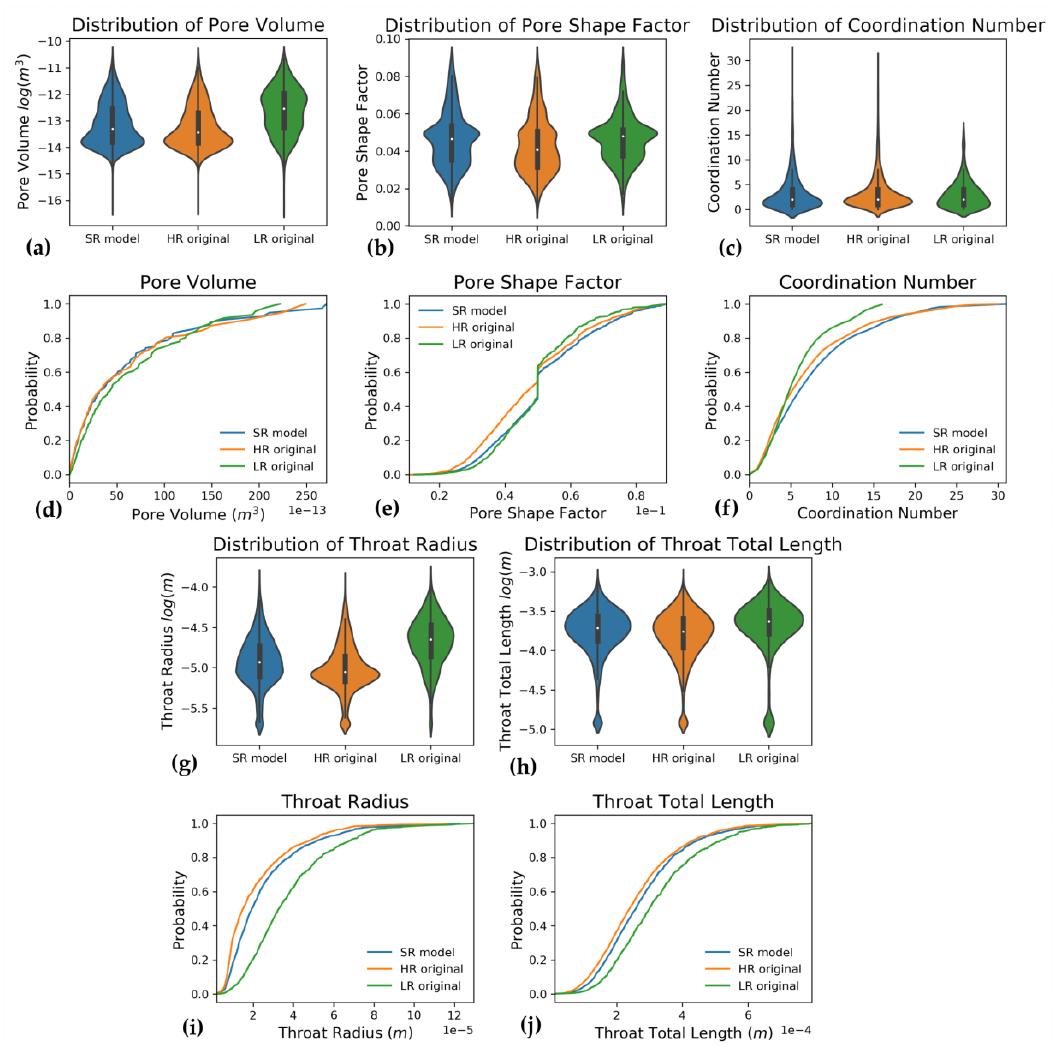
Figure 7. Study of effect of SR models. Pore network properties of Low Resolution model input, super-resolved (SR) model output and the expected high resolution output in cumulative distribution and violin plots. Only data from first volume (V1) is shown. Pore volume distribution ( a , d ) is closer to HR for SRM than LR and pore shape factor distribution ( b , e ) of SRM is in between distributions of LR and HR. Coordination number ( c , f ) is better approximating HR in SRM than in LR. Pore throat radii ( g , i ) and lengths ( h , j ) are also better reproduced by SRM than LR can